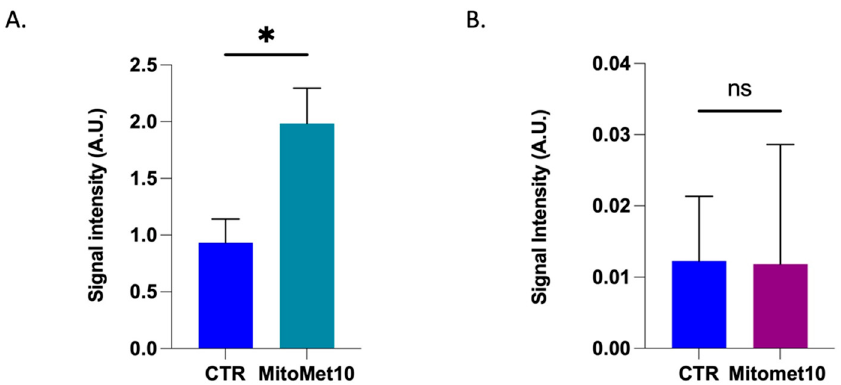
Figure 3. Impact of MM10 on mitochondrial superoxide level in prostate cancer cells measured by EPR spectroscopy. Mitochondrial superoxide was measured using mitoTEMPO-H as EPR sensor.